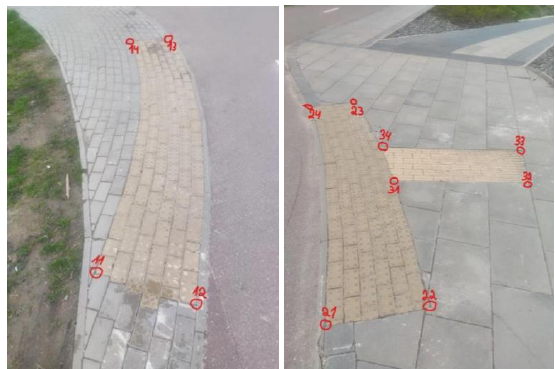
Figure 4 . Coordinated 16 GCP points in the area.